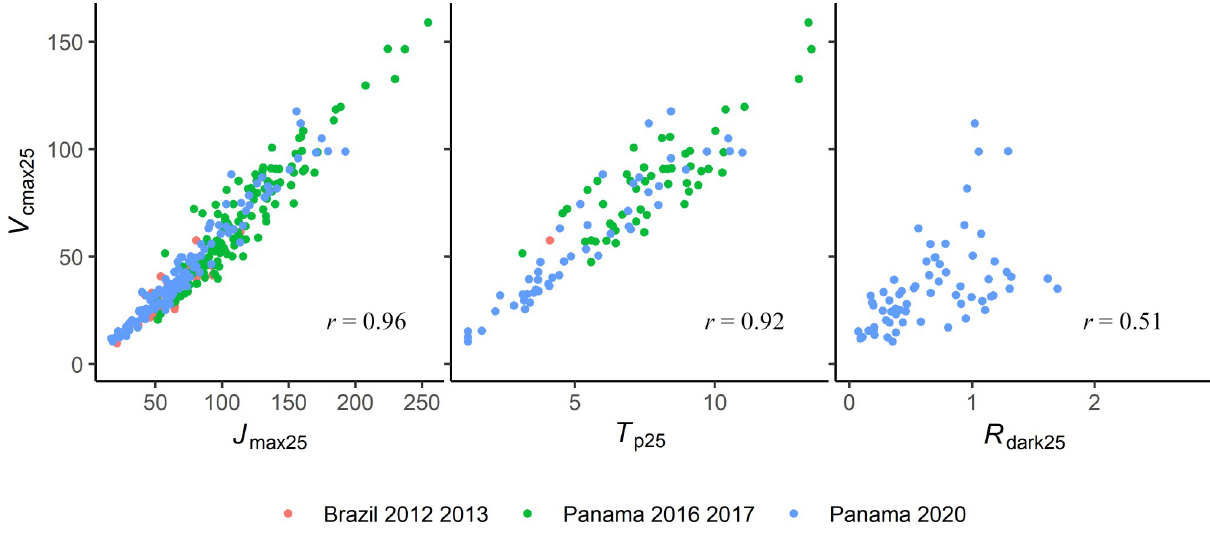
Fig 6. Scatter plot between V cmax25 and J max25 , T p25 and R dark25 . The coefficient of correlation ( r ) is indicated on each